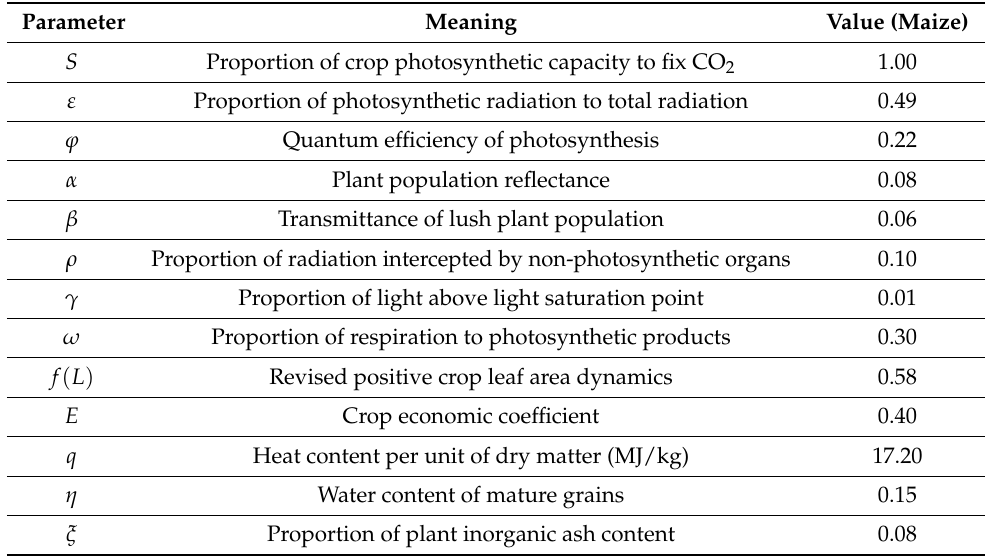
Table 3. Meaning and values of the parameters for calculating photosynthetic production potential. Parameter Meaning Value (Maize) S Proportion of crop photosynthetic capacity to fix CO 2 1.00 ε Proportion of photosynthetic radiation to total radiation 0.49 ϕ Quantum efficiency of photosynthesis 0.22 α Plant population reflectance 0.08 β Transmittance of lush plant population 0.06 ρ Proportion of radiation intercepted by non-photosynthetic organs 0.10 γ Proportion of light above light saturation point 0.01 ω Proportion of respiration to photosynthetic products 0.30 f ( L ) Revised positive crop leaf area dynamics 0.58 E Crop economic coefficient 0.40 Heat content per unit of dry matter (MJ/kg) 17.20 Water content of mature grains 0.15 Proportion of plant inorganic ash